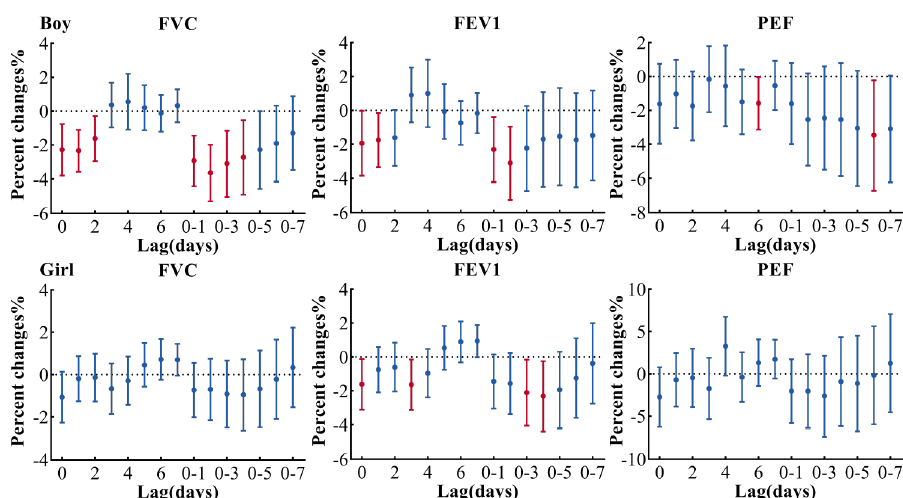
Figure 4. Association between lung function and PM 2.5 in gender-stratified multi-pollution model (adjusted PM 2.5 + SO 2 + O 3 ). Estimates are adjusted for questionnaire information, relative humidity, temperature, age, BMI, holiday, day of week and times of the measurement. FVC, forced vital capacity; FEV1, forced expiratory volume in 1 s; PEF, peak expiratory flow.